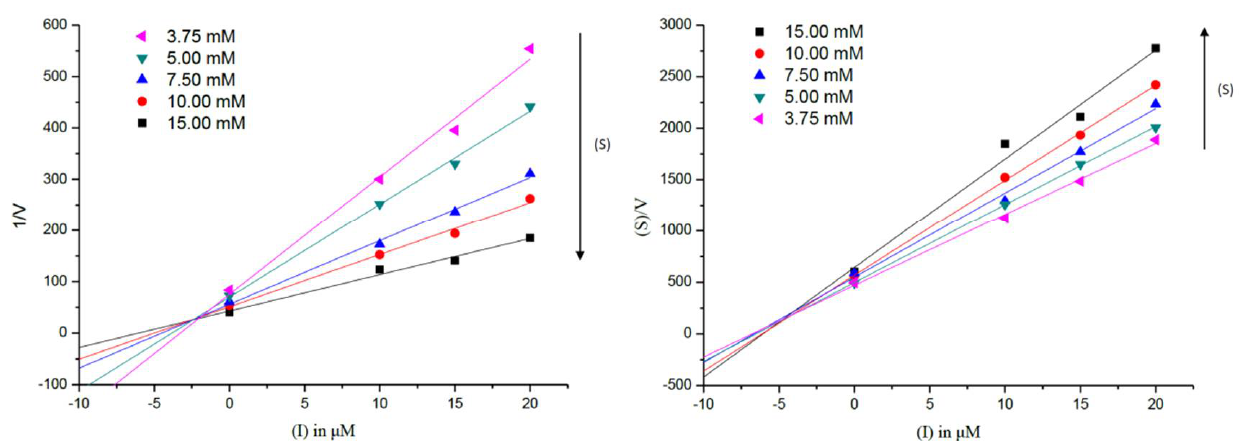
Figure 5. Dixon ( left ) and Cornish–Bowden ( right ) plots for most active AChE inhibitor 1 .